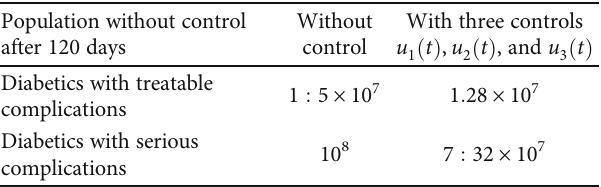
Table 4: Evolution of number of diabetics with three controls u t Þ , u t Þ , and u t Þ after 120 1 ð 2 ð 3 ð